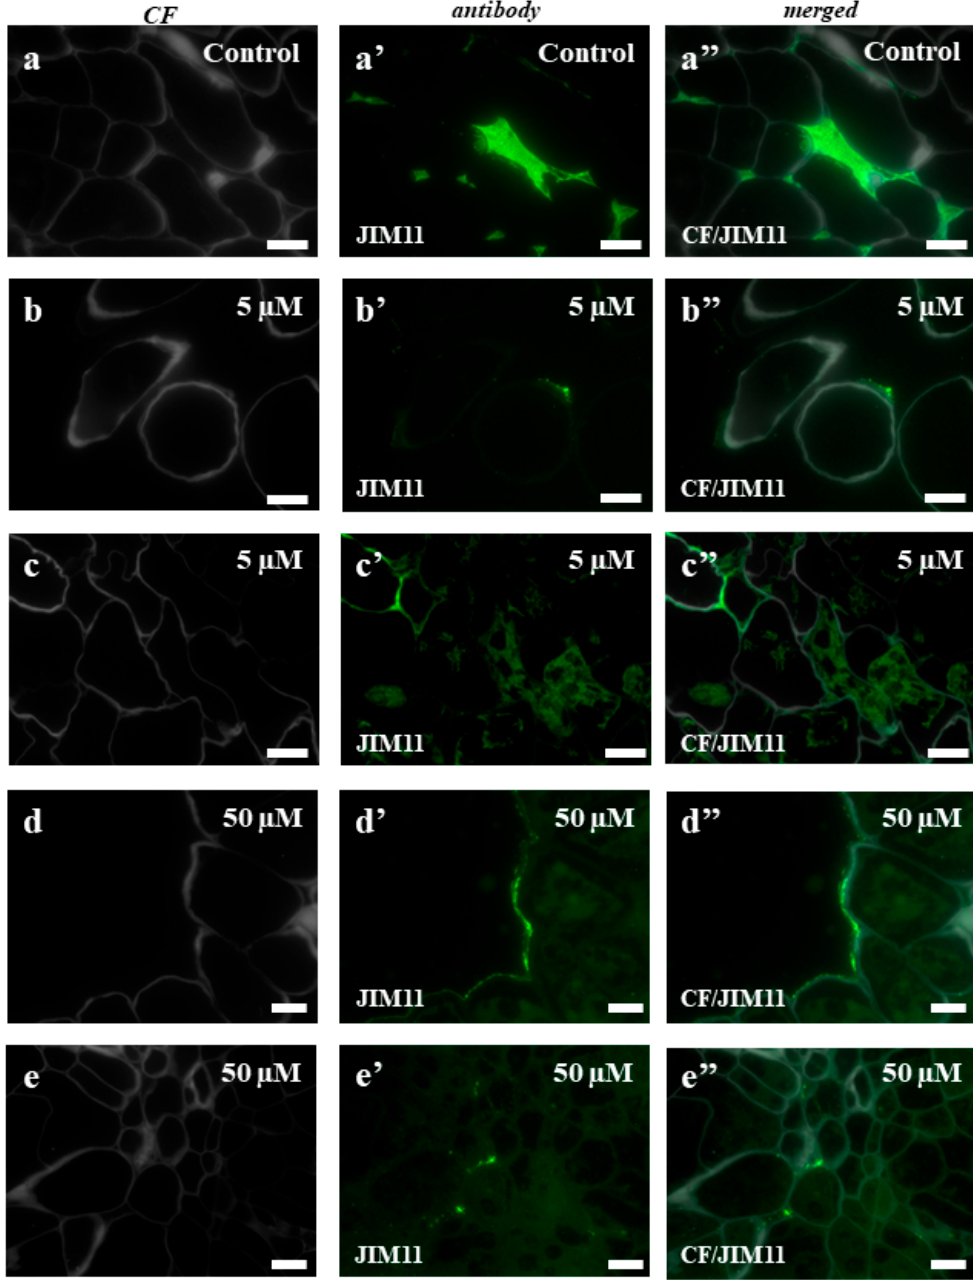
Figure 8. Immunolocalization of JIM11 in the Brachypodium callus. ( a – a” ): control callus. ( b – b” ), ( c – c” ): callus that has been treated with 5 µM of 5-azaC. ( d – d” ), ( e – e” ): callus that has been treated with 50 µM of 5-azaC. The greenish background on these photomicrographs is due to the autofluorescence. Scale bars, 10 µm.